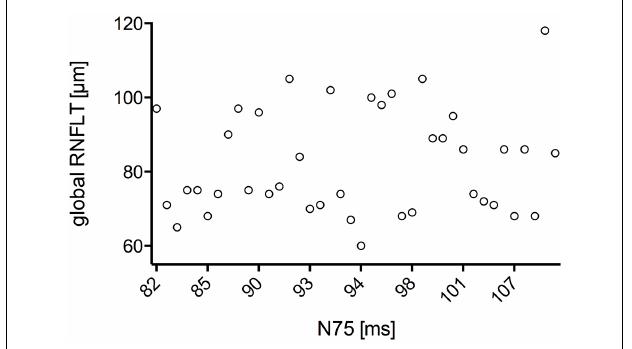
FIGURE 3 | Scatter plot of all N75 latencies in dependence of the associated global RNFLT .There was no significant correlation found for